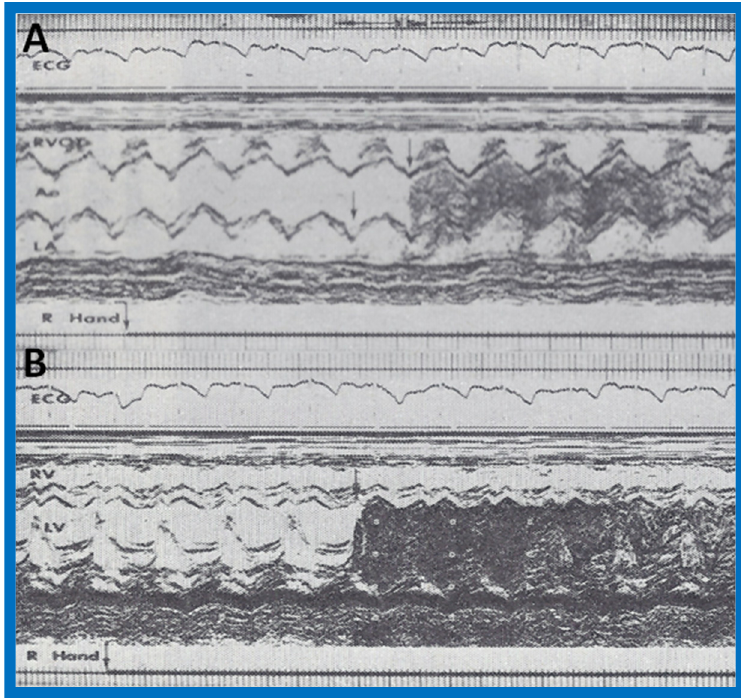
Figure 4. Selected M-mode recordings from the parasternal short axis view of the left atrium (LA), aorta (Ao), and right ventricular outflow tract (RVOT) while injecting agitated saline into veins of the right (R) hand ( A ) demonstrating the appearance of contrast echoes in the LA (arrow) first and then Ao (arrow). Similar tracings of the left ventricle (LV) and right ventricle (RV) ( B ) demonstrate appearance of contrast echoes in the LV (arrow) without contrast in the RV. Similar findings were seen while injecting agitated saline into veins of the left hand. These recordings indicate drainage of the superior vena cava into the left atrium. The start of agitated saline injection is marked with arrows at the bottom of each tracing. ECG, electrocardiogram. Reproduced (modified) from Truman T.A., Rao P.S., Kulungara R.J. [2].